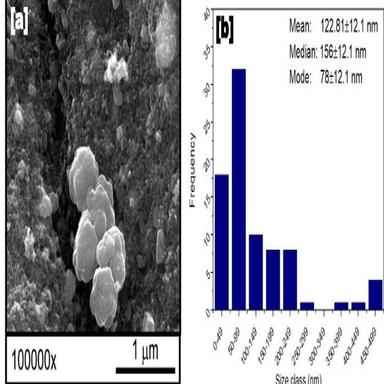
(a) SEM image (magnification 100000x) and (b) size distribution histogram for nZVSI